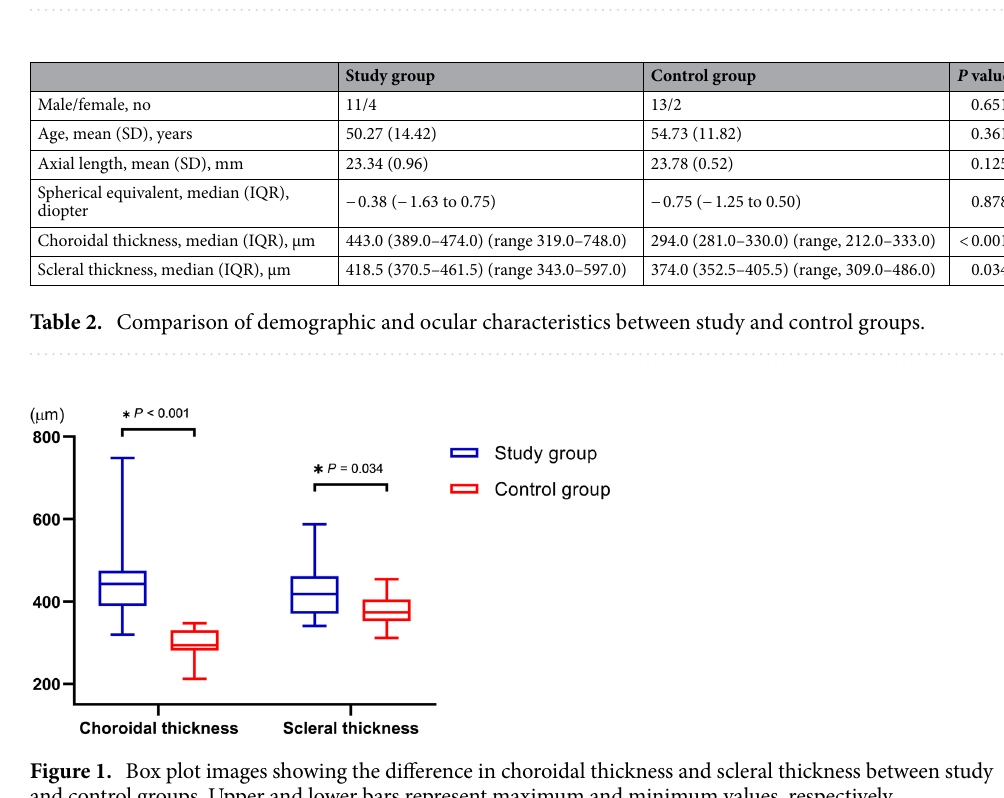
Table 1. Characteristics of study groups related to CSC. CSC central serous chorioretinopathy, MRA mineralocorticoid receptor antagonist, VEGF vascular endothelial growth factor, CHD coronary heart disease, HTN hypertension. a FA was not performed because of pregnancy.